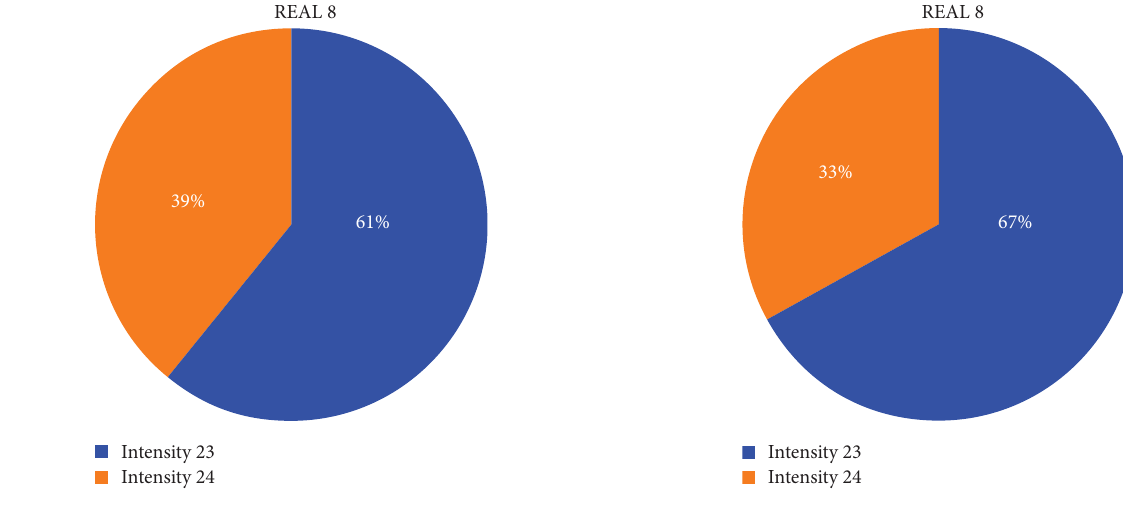
F IGURE 11: REAL 8 result distribution without local search mechanism.